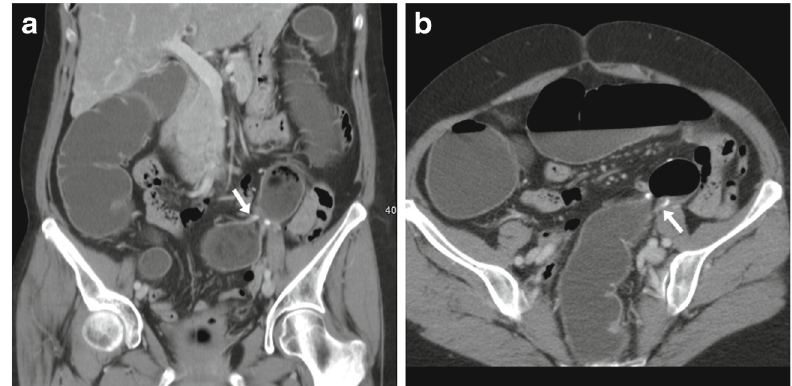
and distended rectum with suture (arrows) and very thin presacral space; left colon flexure occupying the site of splenectomy, indissociable from splenosis nodules (arrowheads) unchanged from previous studies